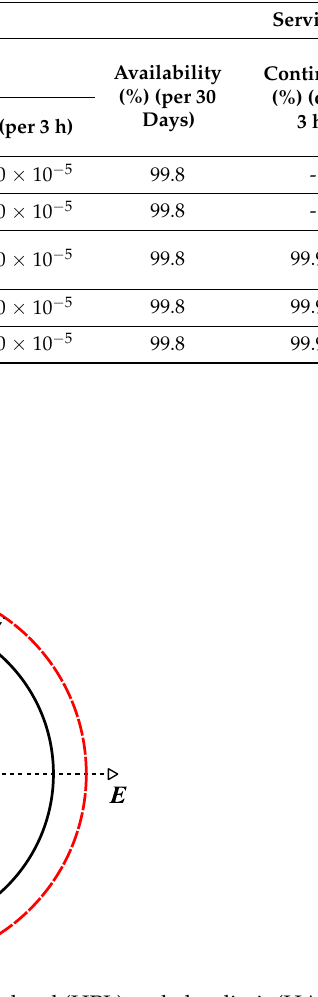
Figure 2. Horizontal protection level (HPL) and alert limit (HAL) (based on [19]).